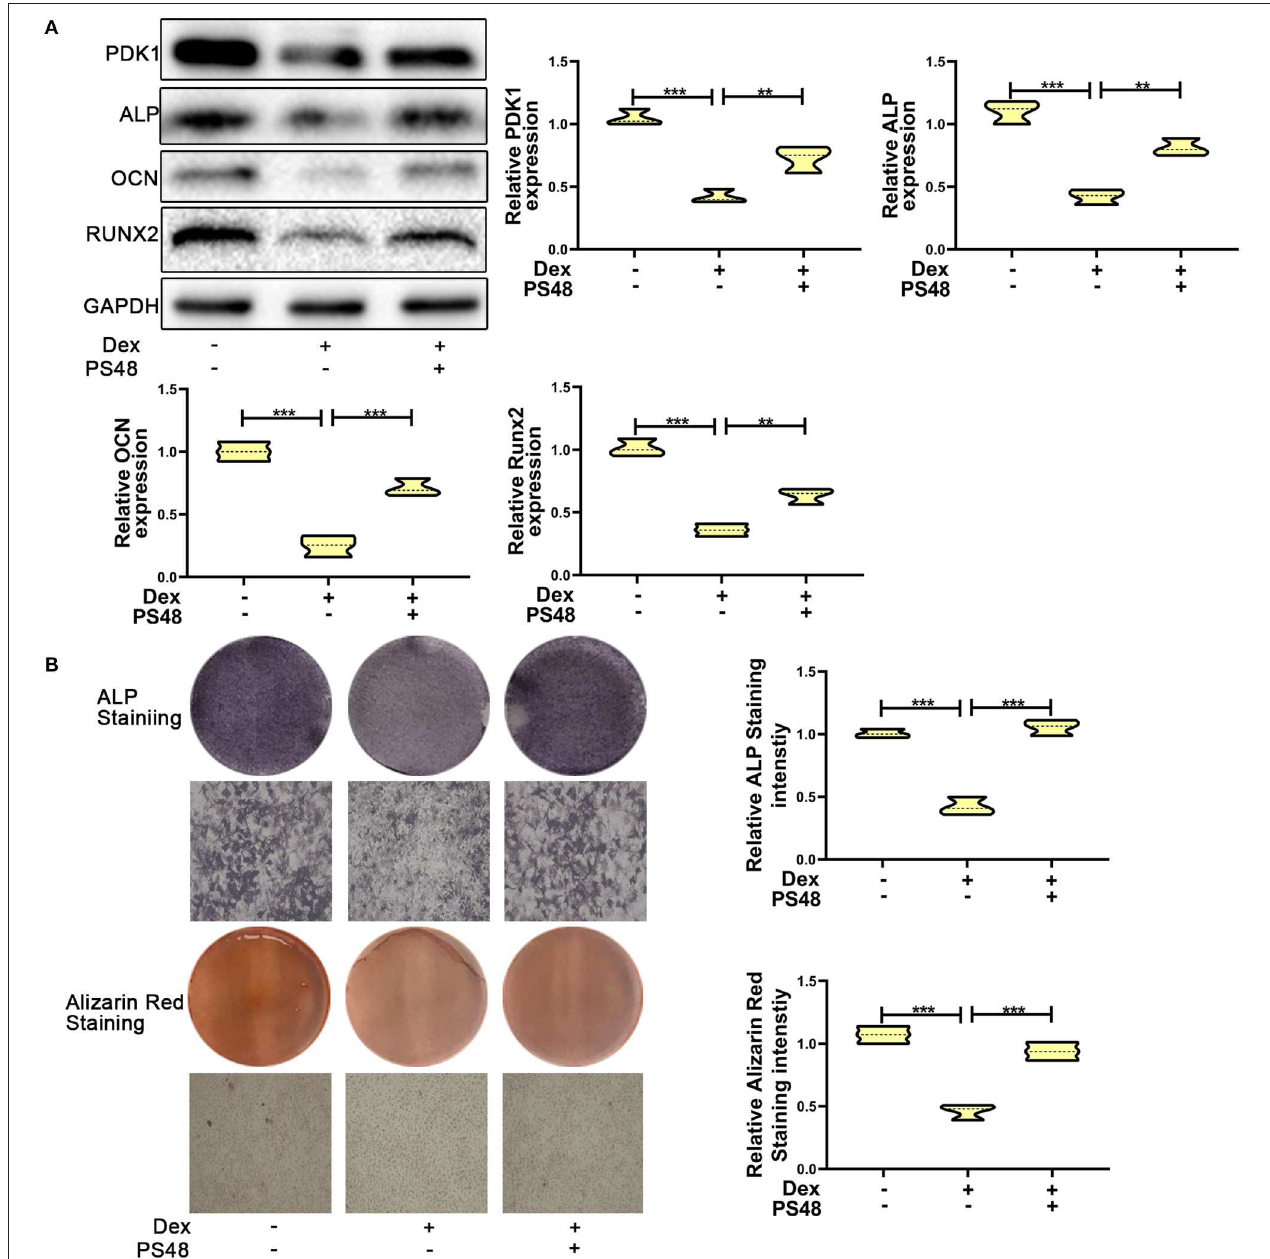
FIGURE 4 | Upregulation of PDK1 promoted the osteogenic ability of MC3T3-E1 cells. (A) Western blotting was performed to detect the protein expression levels of PDK1 and osteogenic markers Runx2, OCN, ALP, PDK1, and GAPDH in MC3T3-E1 cells exposed to empty vector, dexamethasone, and dexamethasone + PS48, respectively. (B) ALP and Alizarin red staining were performed to determine the osteogenic ability of MC3T3-E1 cells exposed to empty vector, dexamethasone, and dexamethasone + PS48, respectively. Scale Bar = 20 µ m. Differences were considered as statistically significant when p < 0.05. *** p < 0.001, ** p < 0.01, * p <